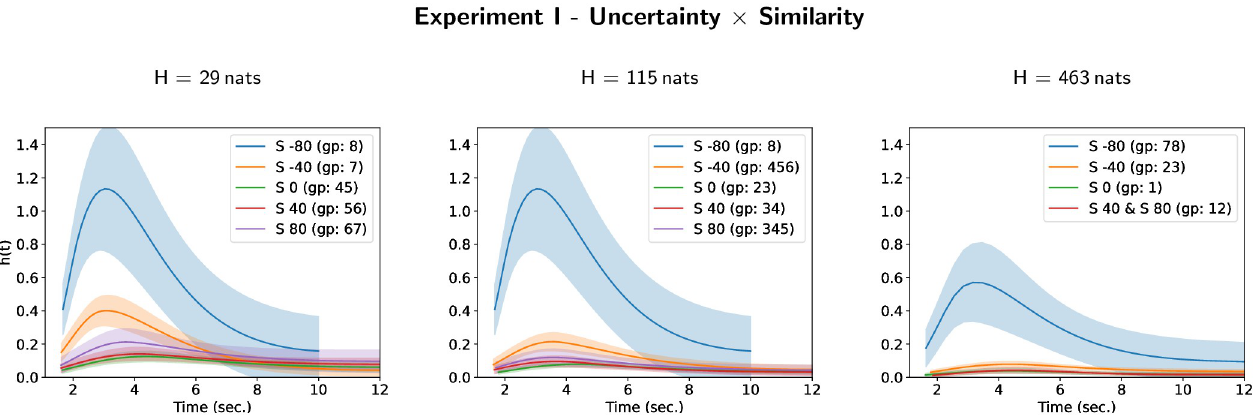
Fig 3. Hazard rate functions h ( t ) for masker uncertainty and masker-target similarity in Experiment I. Each figure depicts the estimates of the hazard rate functions for each different group of the compact letter display for experimental conditions defined by the interaction between masker uncertainty and masker-target